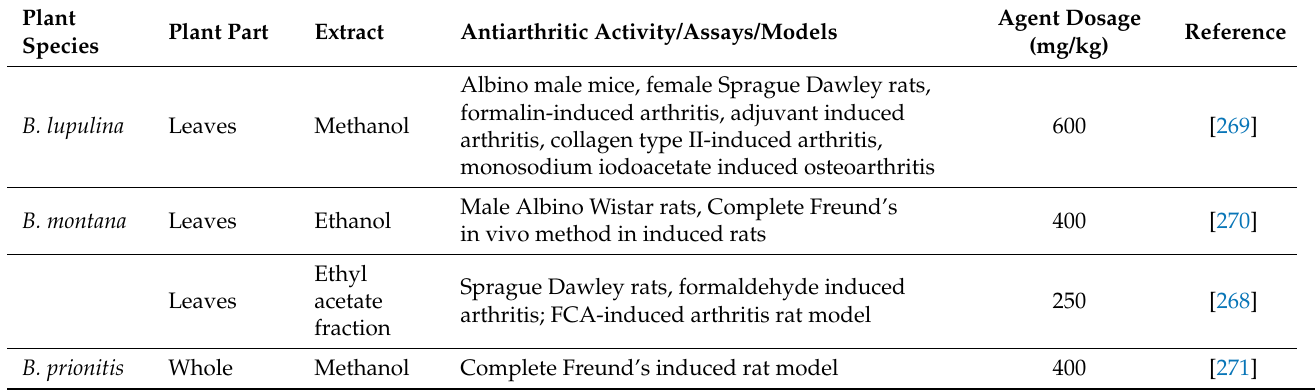
Table 11. Antiarthritic activities of extracts and fractions from species within Barleria